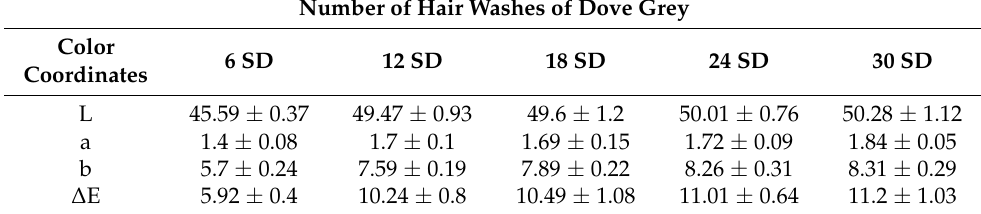
Figure 6. Box and whisker plots of color change ∆ E—values after washing numbers of 6 to 30 of dyed hair tresses with 10 wt% matcha in combination with 1 wt% iron(II)-lactate compared to hairs tresses dyed with Dove Grey and the corresponding photographs of the hair tresses from the reference 0 hair washes to 30 hair washes (n = 5). SE: standard error. Table 3. Color coordinates, L, a, b, and ∆ E of hair tresses dyed with commercial hair color Igora Royal Silverwhite Dove Grey (n = 5). SD: standard